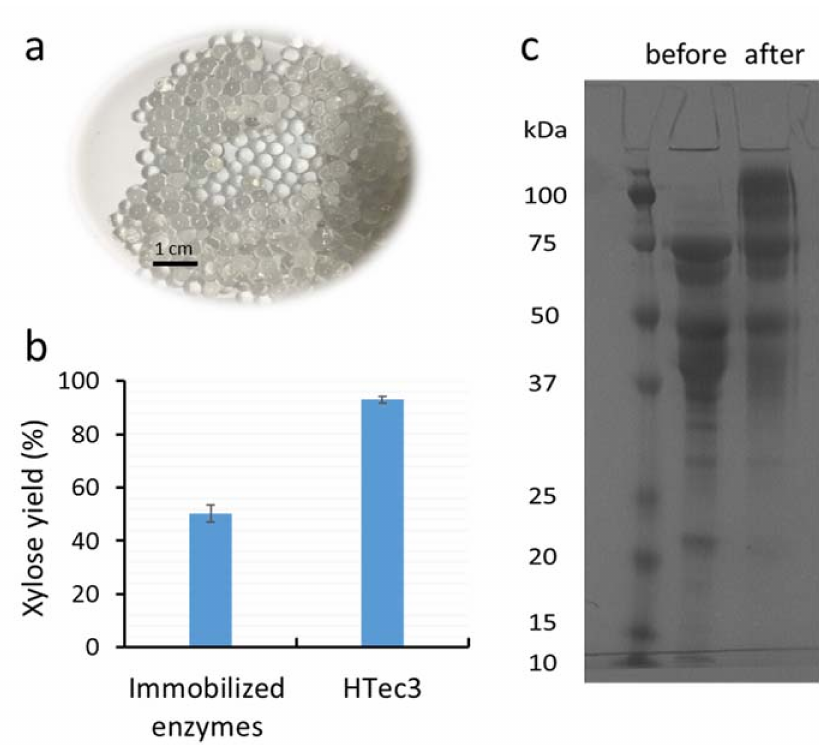
Figure 1. ( a ) Alginate beads activated with glutaraldehyde (3%, w / w ) for enzyme immobilization; ( b ) the xylose yield of xylooligomer-enriched pre-treatment liquors after 24 h hydrolysis using either immobilized HTec3 (xylanases) or non-immobilized HTec3; and ( c ) SDS-PAGE of the HTec3 enzymes remaining in solution before (left column) and after immobilization (right